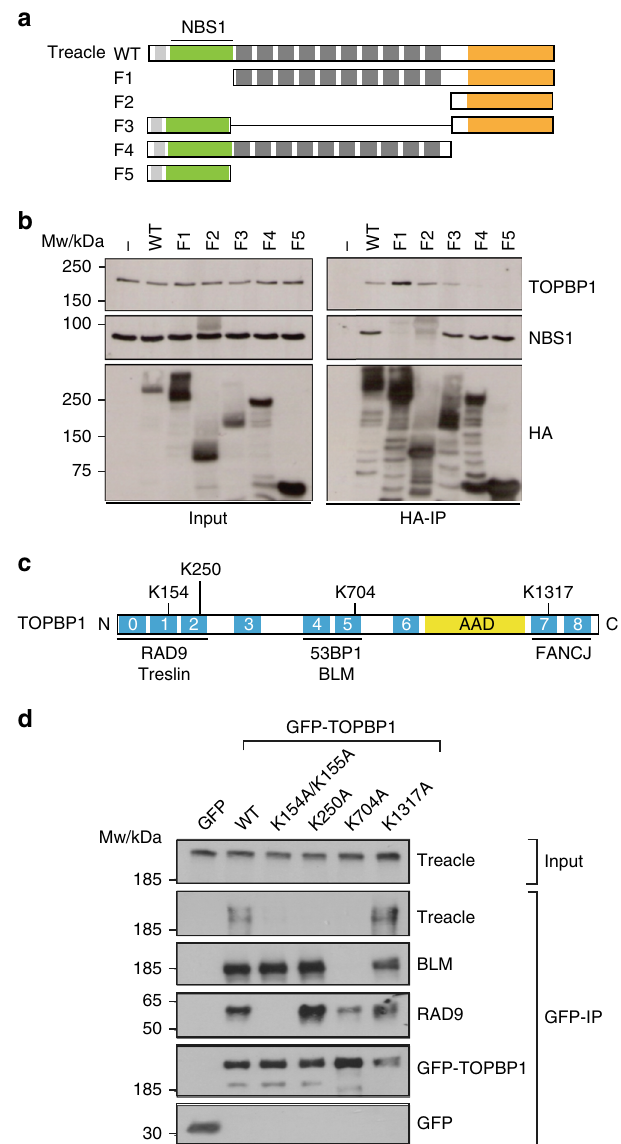
Fig. 5 Characterization of the TOPBP1 – Treacle interaction. a Schematic showing the layout of conserved domains and motifs in Treacle as well as HA-tagged deletion constructs of Treacle, lacking either the N-terminal region (F1), both the N-terminal and the central repeat region (F2), the central repeat region (F3), the C-terminal region (F4) or both the central repeat and the C-terminal region (F5). HA-immunoprecipitation of full- length and fi ve deletion constructs depicted in a . c Schematic showing the layout of conserved domains and motifs in TOPBP1. Names of known TOPBP1-binding partners are shown below the domains they interact with and phospho-interacting Lys residues in the three BRCT tandems are highlighted. AAD: ATR-activating domain. d GFP-pulldowns from 293FT cells transfected with the indicated GFP-tagged TOPBP1 constructs. Source data are provided as a Source Data fi